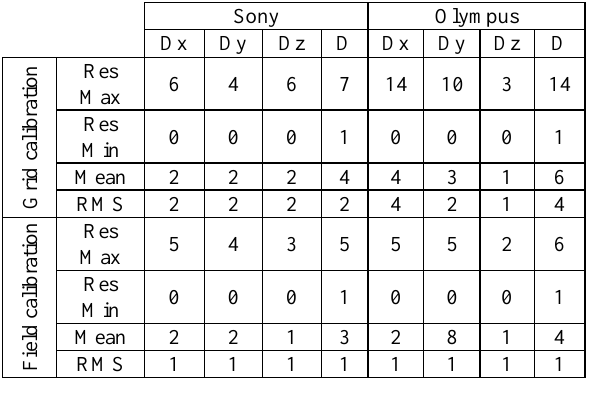
Table 1. First calibration results using three points (results are in mm). Table 1 present the statistics on the residuals in millimetres between the coordinates obtained from the photogrammetric measurement and the total station measurements, where Dx, Dy, Dz are the residuals in the X, Y and Z directions and D on the